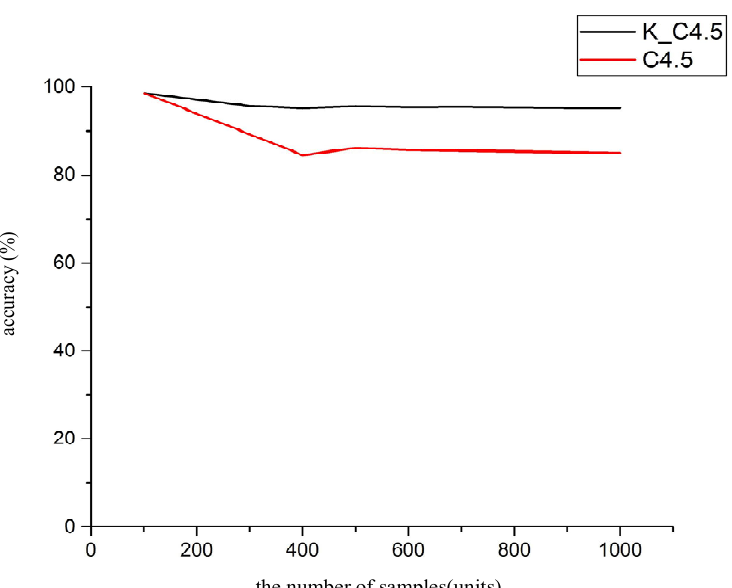
Figure 4. Comparison of the accuracy of the two algorithms.